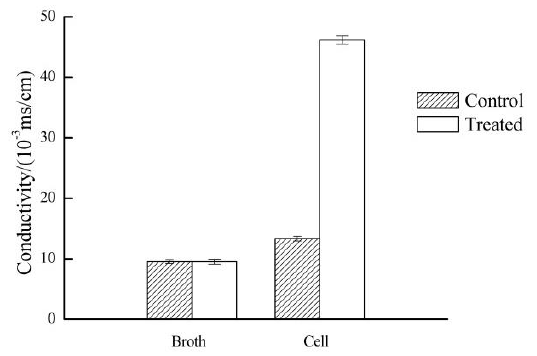
Figure 3. Effect of APLTP treatment on E. coli conductivity.